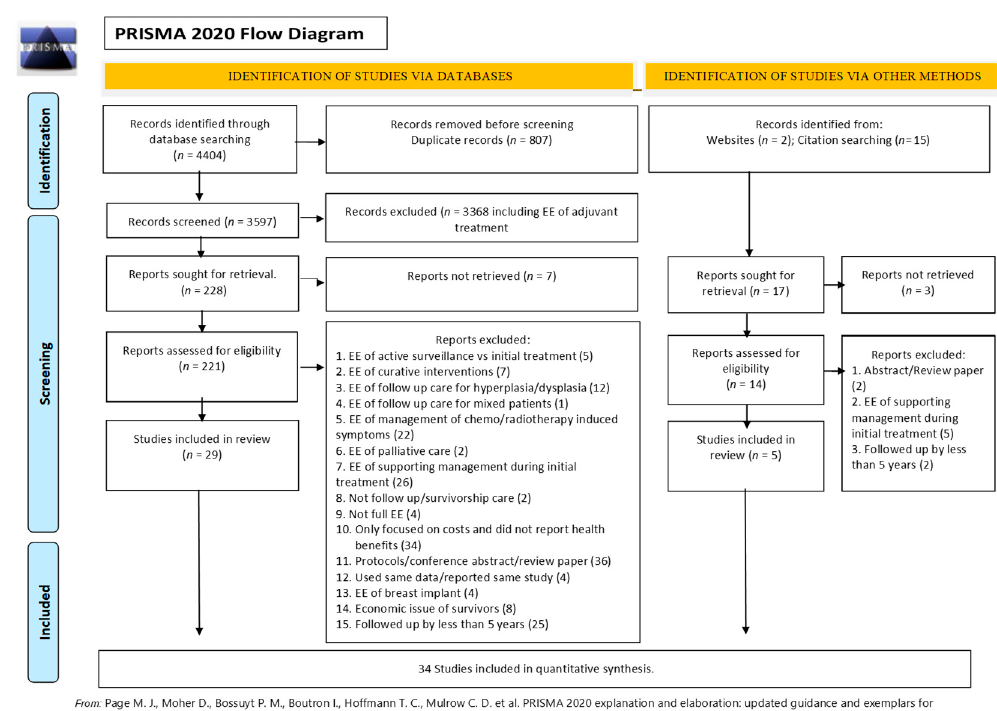
Figure 1. PRISMA flow diagram showing the process of study selection for inclusion in the systematic review.